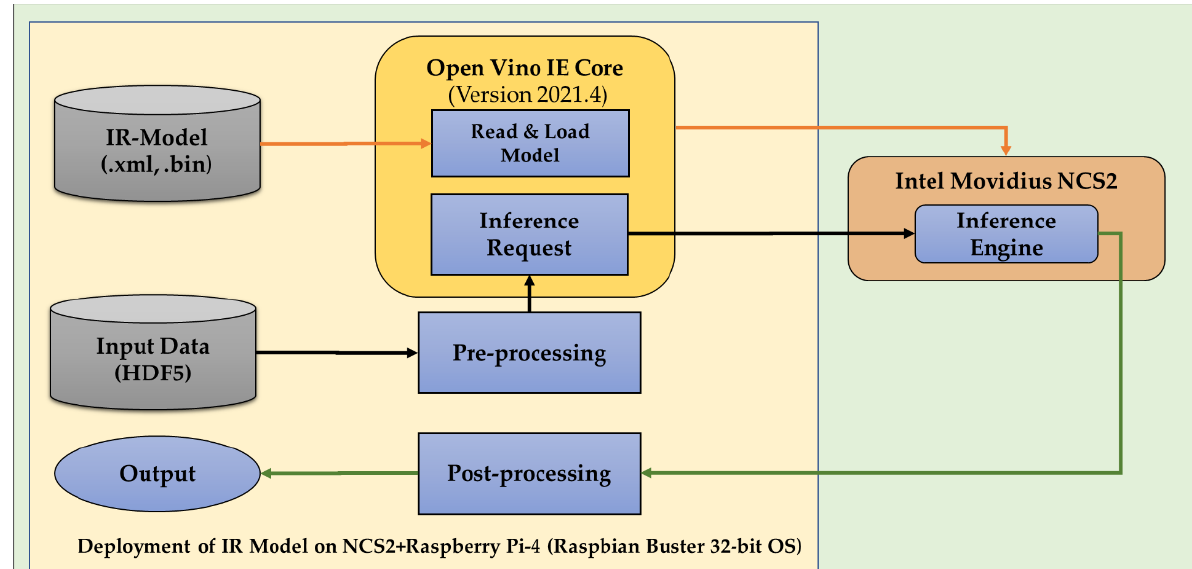
Figure 7. High-level representation of the Keras model to IR model conversion through the TF saved model and model optimiser.